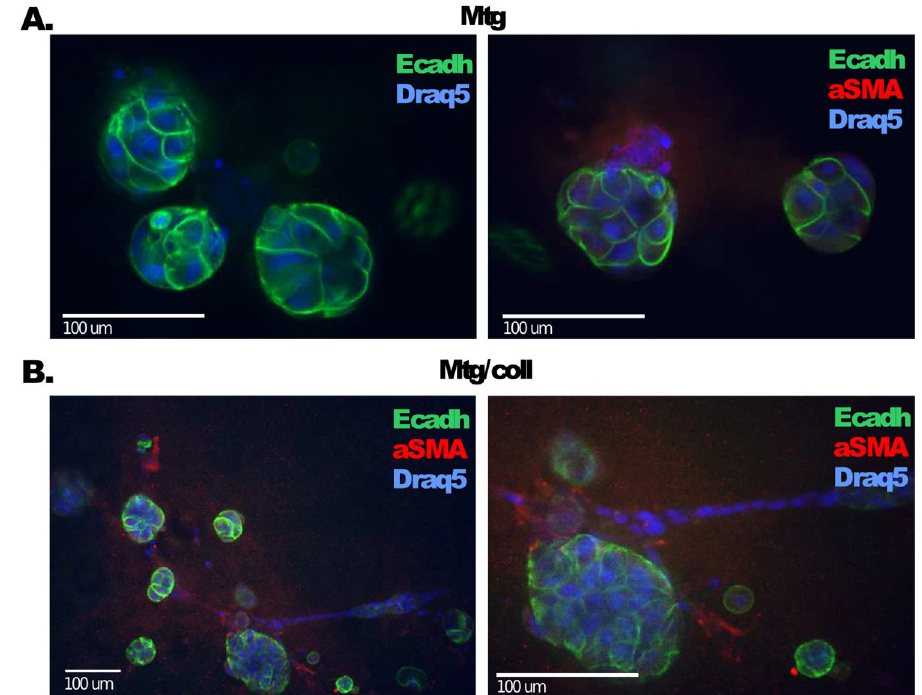
Figure 2. Characterization of PDX microtissues using immunofluorescence. The fibroblasts-tumor interaction was characterized in different ECM preparations. ( A ) Matrigel and ( B ) in Matrigel/collagen mixture. Fibroblasts require collagen for growth and spreading. Roundish tumor organoids express epithelial markers such as E-cadherin (Ecadh; green), whereas the fibroblasts express mesenchymal markers such as alpha-Smooth Muscle Actin (aSMA; red). Nuclei are stained with Draq5 (Blue). Scale bars: 100 μ m